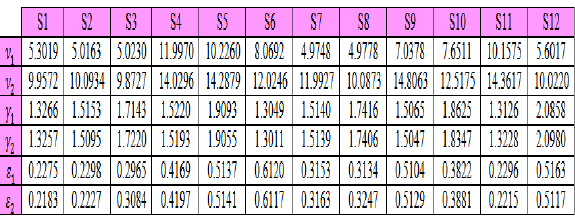
Figure 11: Backscattering coefficient dependence on ε 2′ at HH polarization for bare soil (dashed line) and for vegetated soil (full line)